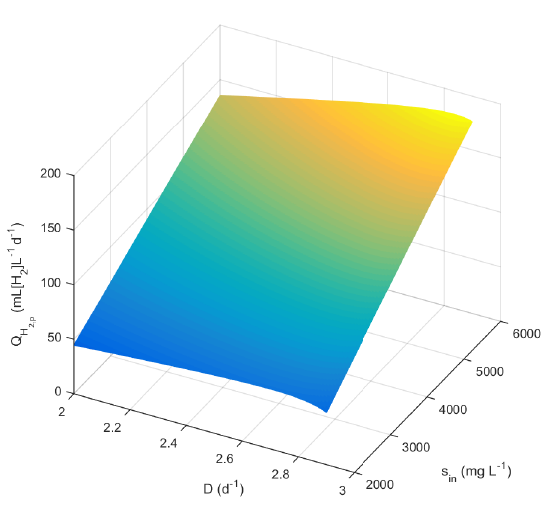
Figure 2. MEC hydrogen productivity rate in steady state on the operating